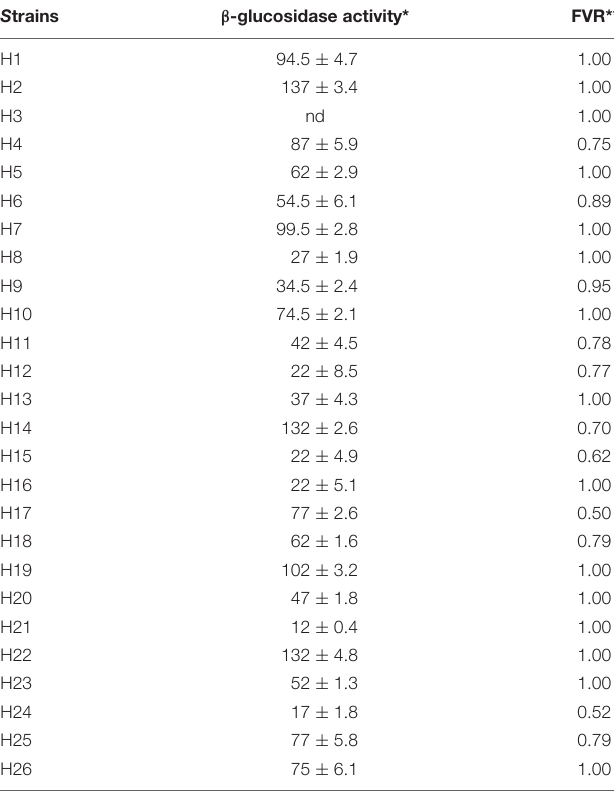
TABLE 2 | Technological characterization of H. uvarum strains.